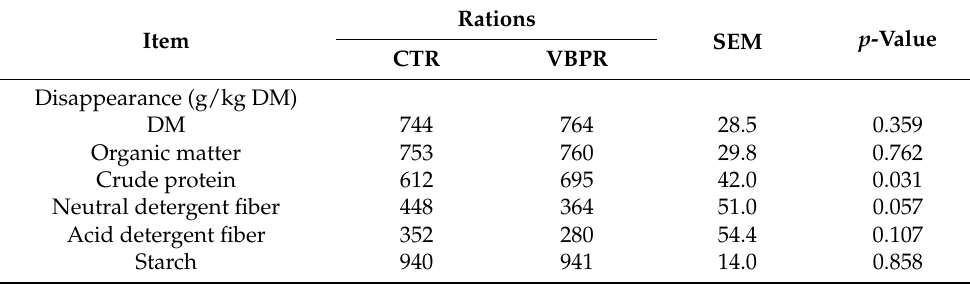
Table 6. In vitro ruminal nutrient disappearance of the experimental rations.